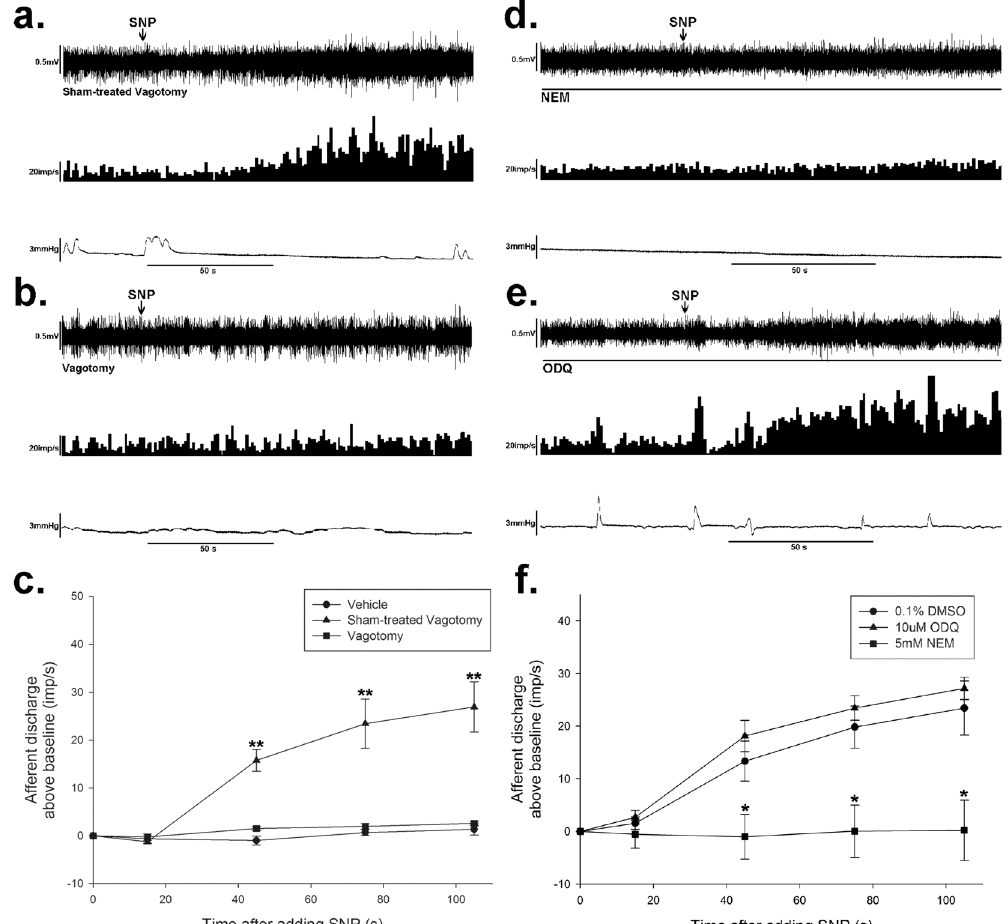
Figure 4. The excitatory effect of SNP was abolished by prior subdiaphragmatic vagotomy and S-nitrosylation blocker NEM. ( a ) Response of whole nerve activity before and after SNP administration on sham-operation rats. The upper trace shows the raw recording of whole nerve discharge, the middle trace is the number of nerve discharge in 3 s, and the lower trace shows corresponding intraluminal pressure. The arrows indicate the administration of SNP (0.16 mM). Sham-operation of vagotomy didn’t change the effect of SNP to increase the spontaneous afferent discharge. ( b ) Response of whole nerve activity to SNP on subdiaphragmatic vagotomy rats. SNP failed to increase the spontaneous afferent discharge. ( c ) Summary values showing that the excitatory effect of SNP (0.16 mM) was eliminated by vagotomy. n = 6 in each group, ** P < 0.01 vs vehicle, Dunn’s post hoc test after a one-way ANOVA. ( d ) Response of whole nerve activity to SNP in the presence of NEM (5 mM). SNP (0.16 mM) failed to increase the spontaneous afferent discharge. ( e ) Response of whole nerve activity to SNP in the existence of ODQ (10 µ M). ODQ didn’t change the excitatory effect of SNP on the spontaneous afferent discharge. ( f ) Summary values showing that the excitatory effect of SNP (0.16 mM) was eliminated by NEM (5 mM), while ODQ (10 µ M) had no effect compared to the DMSO group. n = 6 in each group, * P < 0.05 vs DMSO group, Dunn’s post hoc test after a one-way